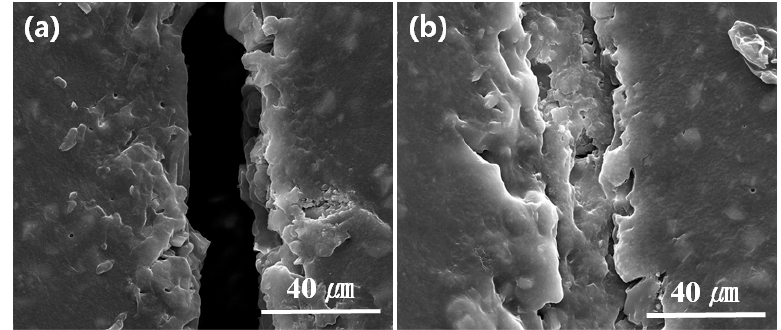
Figure 4. SEM images of scratched ( a ) control and ( b ) self-healing coatings.